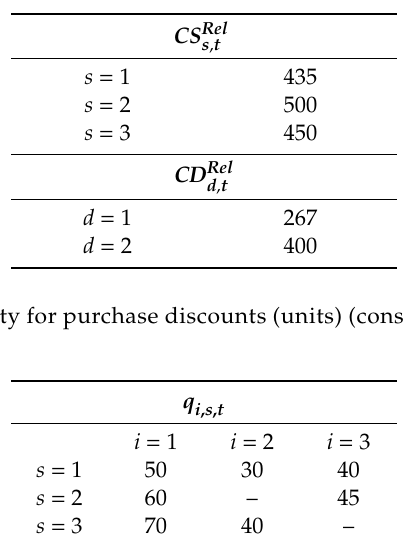
Table A27. Contractual relationship cost ( € ) (considered here the same for any time period).